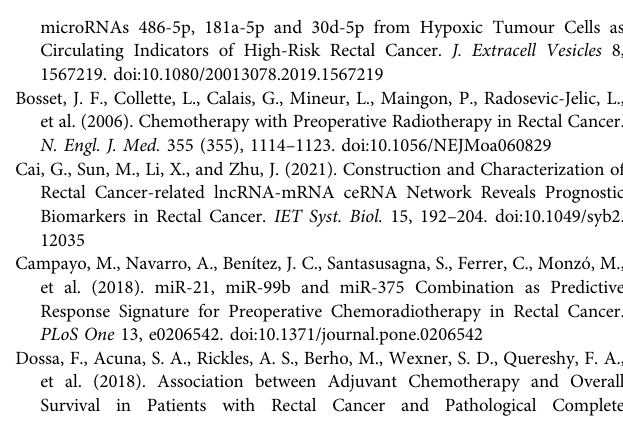
Supplementary Figure S1 | The analysis protocol to identify miRNA-mediated prognosis markers in